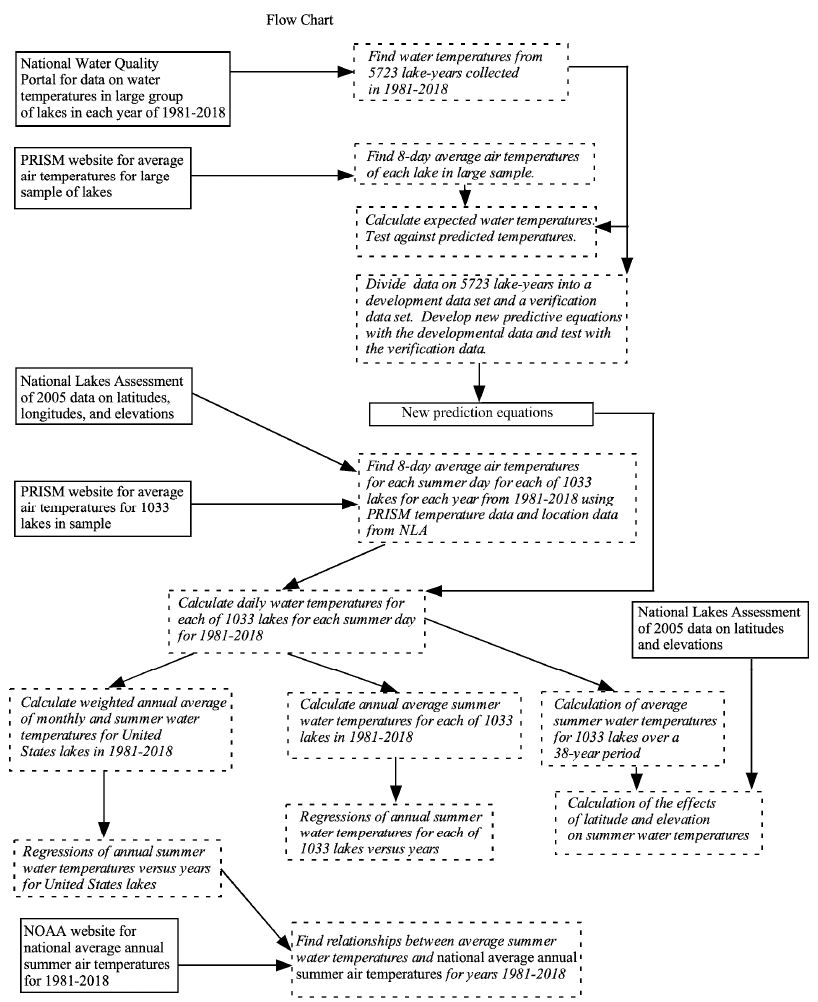
Figure 1. Flow chart for most analyses made in this study. Boxes enclosed with solid lines represent data sources or results of analyses. Boxes enclosed with dashed lines indicate calculations and analyses made with the data. NLA = National Lakes Assessment, NOAA = National Oceanic and Atmospheric